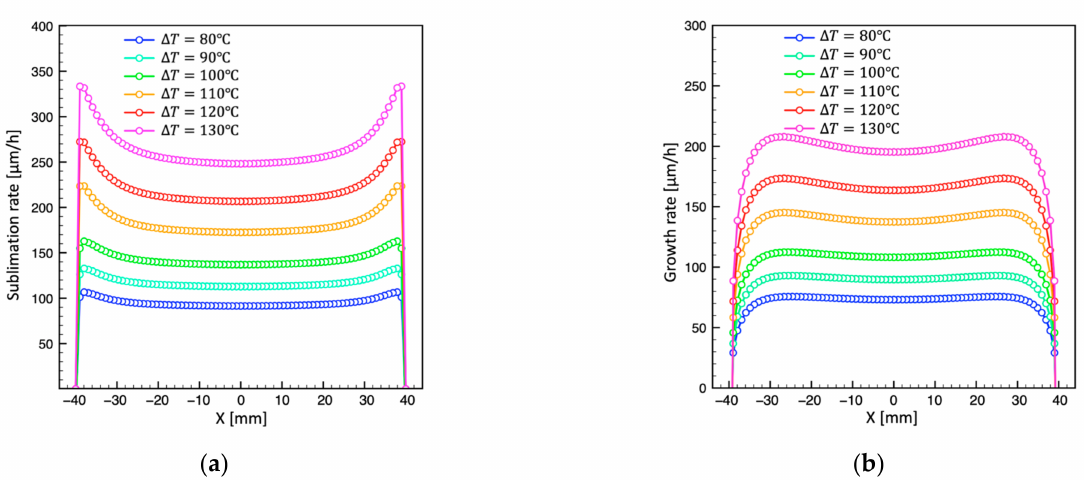
Figure 8. Profiles of the sublimation rate along the top surface of the powder source ( a ) and the growth rate along the seed surface ( b ) at different ∆ T .